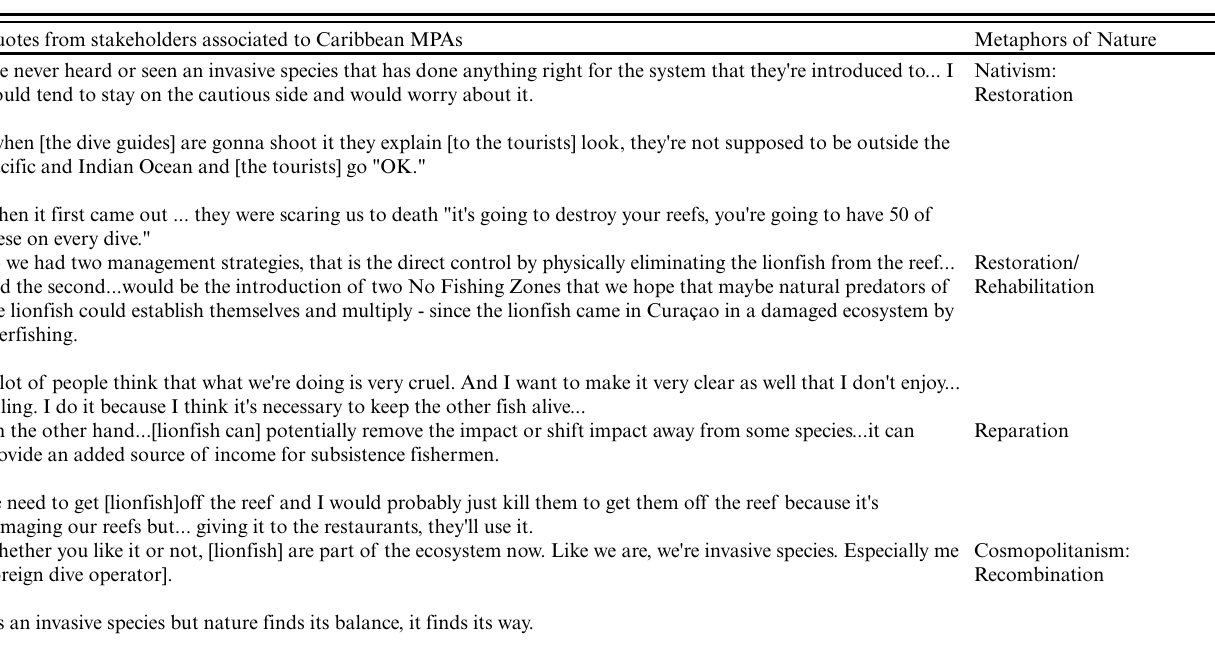
Table 4 . Stakeholders’ discourses on Western Atlantic lionfish ( Pterois